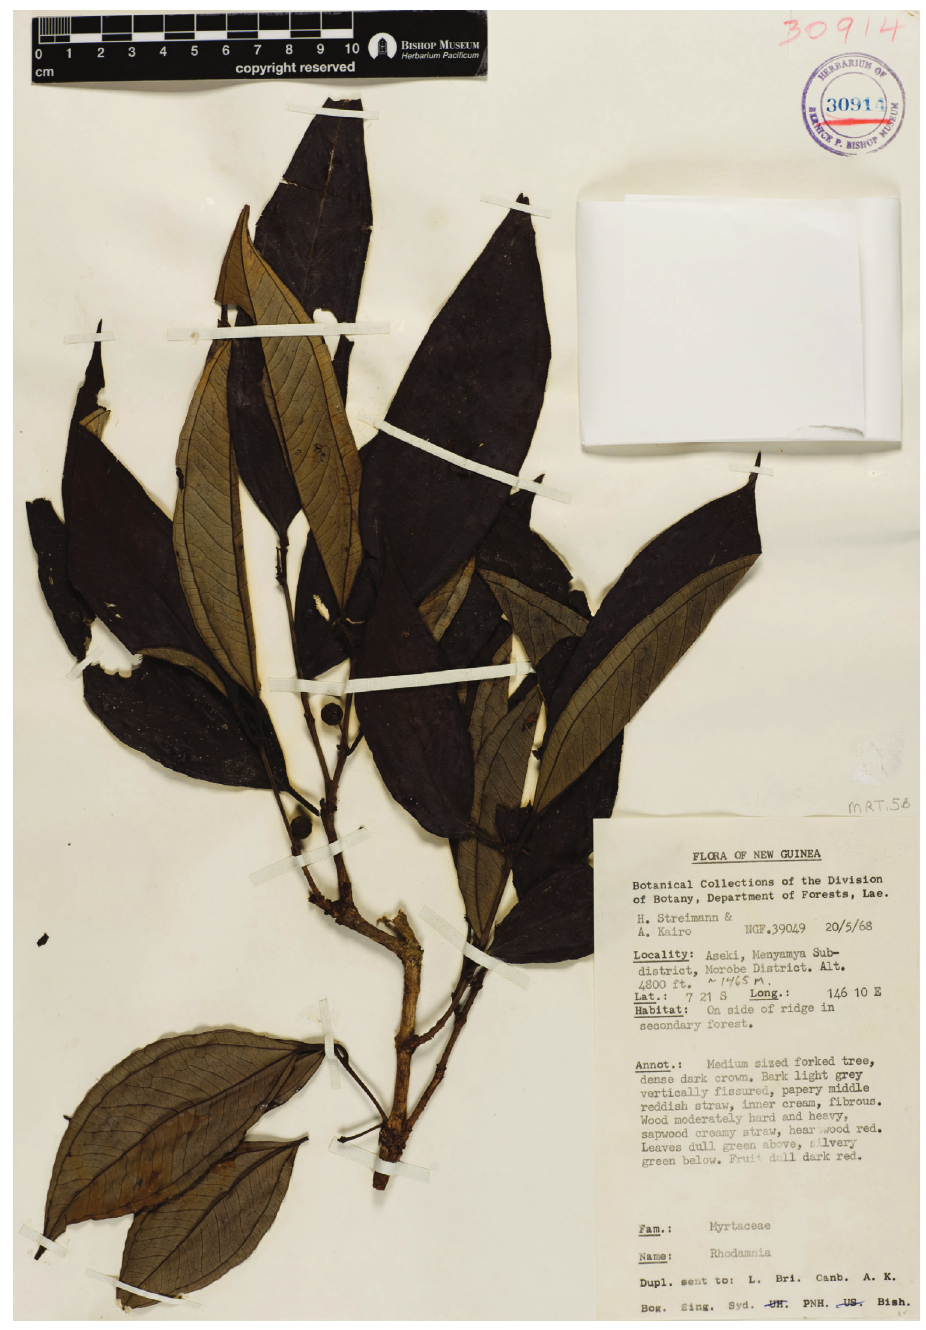
Figure 2. Rhodamnia asekiensis N. Snow. Photo of the holotype at BISH ( H. Streimann and A. Kairo NGF 39049